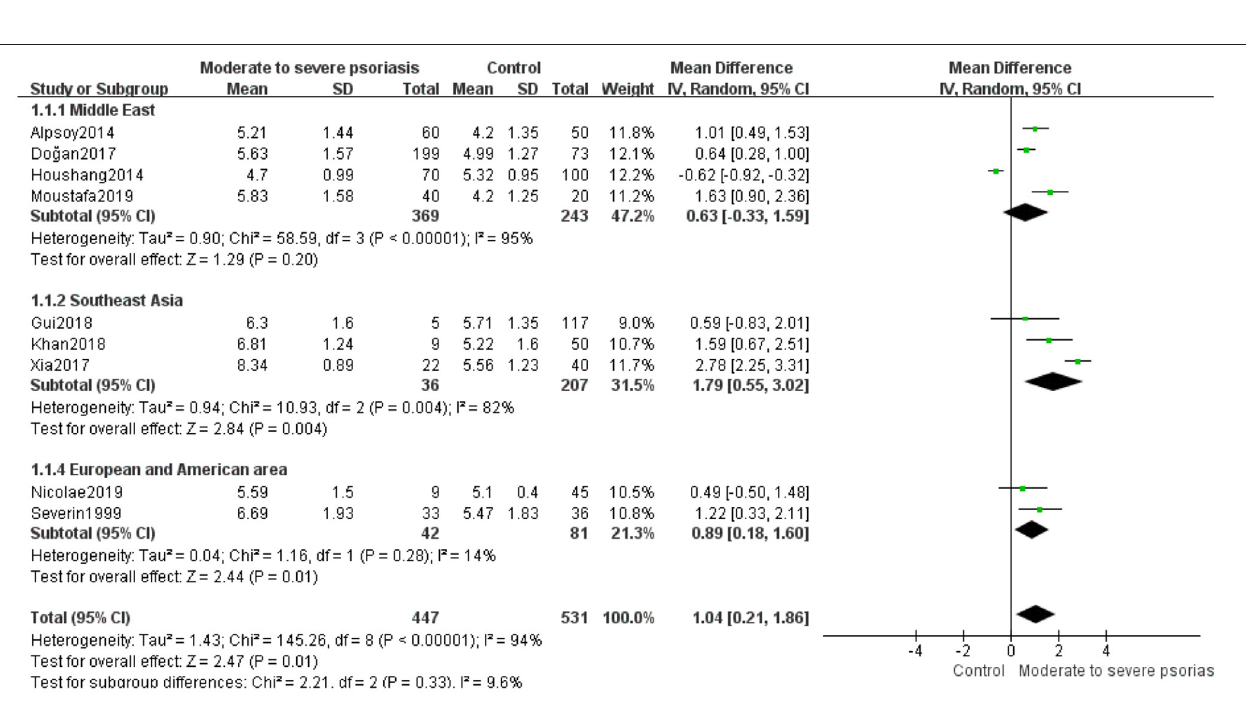
FIGURE 4 | Meta-analysis of the SUA levels of patients with moderate to severe psoriasis vs. controls. The MD in SUA levels of patients with moderate to severe psoriasis vs. controls. The point estimate (center of each green square) and statistical size (proportional area of the square) are represented. The horizontal lines indicate the 95% confidence intervals. The subtotal and total MD (diamond) were calculated using a random-effects model. MD, mean difference; SUA, serum uric acid.